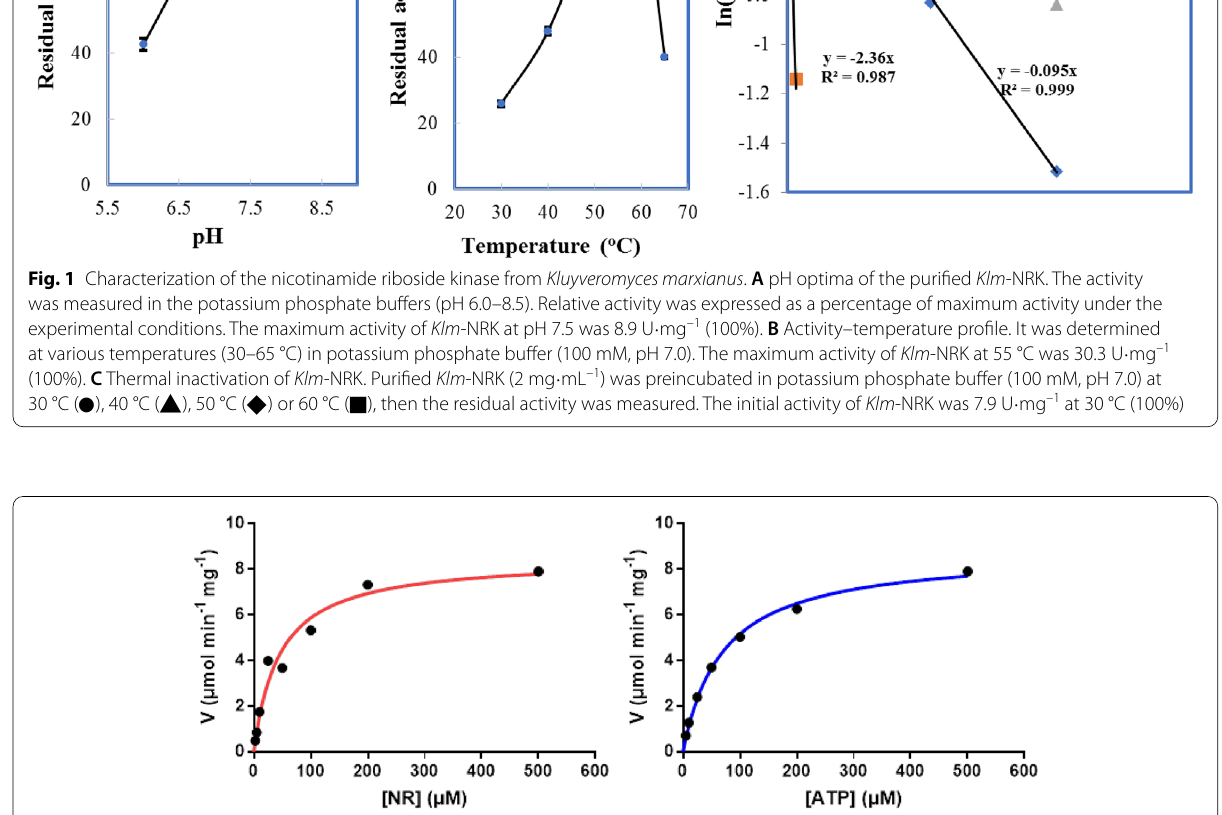
Fig. 2 Michaelis–Menten kinetics of Klm ‑NRK for the substrates NR and ATP. Apparent parameters were determined by nonlinear regression using GraphPad Prism